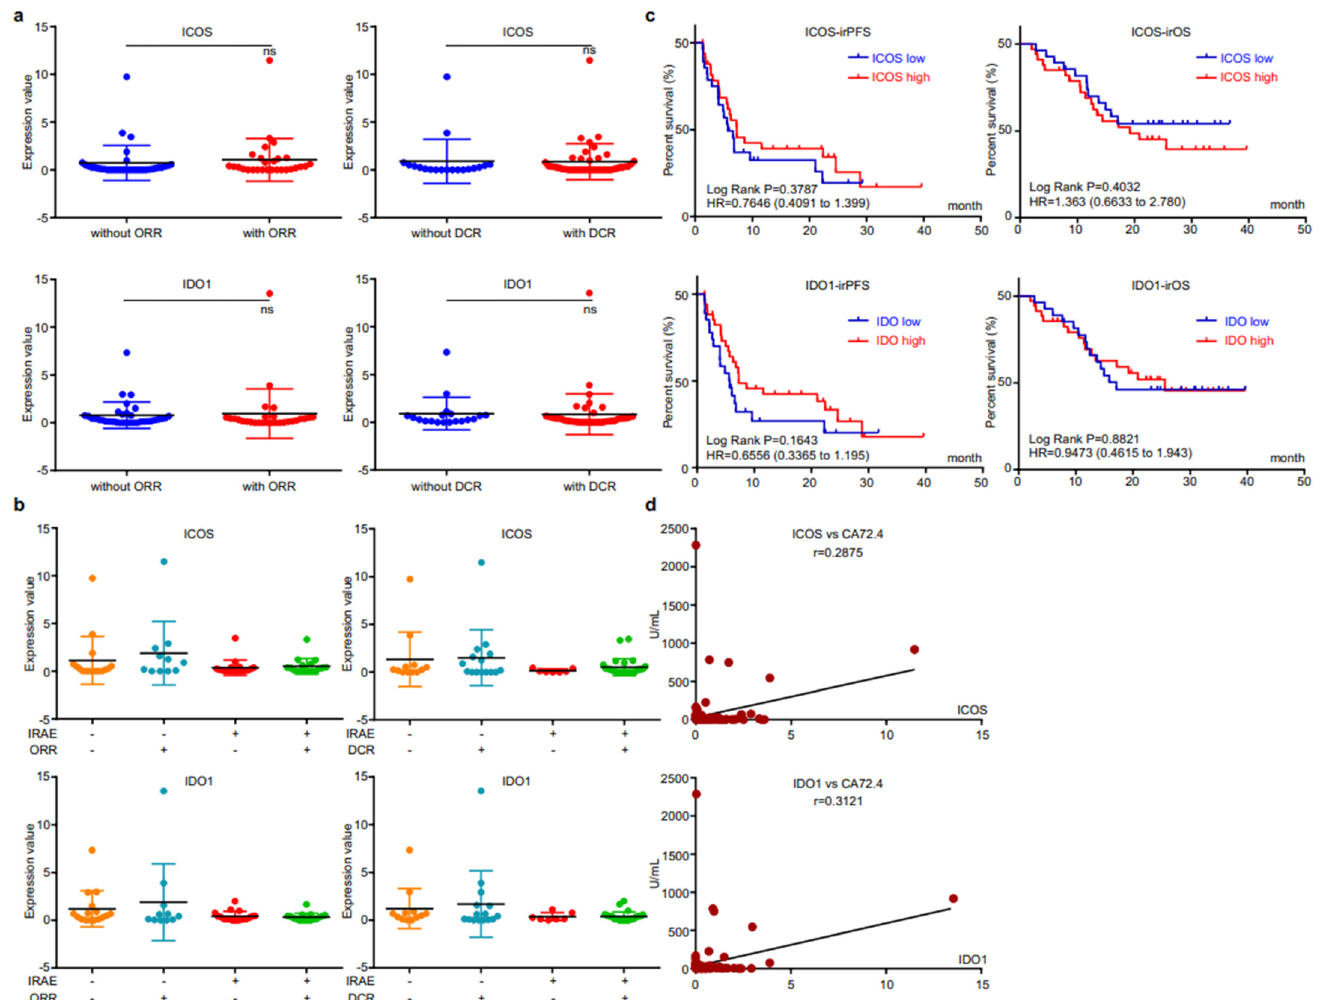
Figure 4. EV-ICOS/IDO1 were irrelevant to immunotherapeutic effectiveness. ( a ) Correlation between EV-ICOS/IDO1 and ORR/DCR. ( b ) The higher value of EV-ICOS/IDO1 suggests a better chance to achieve both therapeutic effectiveness and good safety. ( c ) Relevance of EV-ICOS/IDO1 and irPFS/irOS. ( d ) Relationship between EV-ICOS/IDO1 and the content of circulating tumor marker CA72.4. Different colors represent distinct IRAE and DCR status. ns, non-significant .